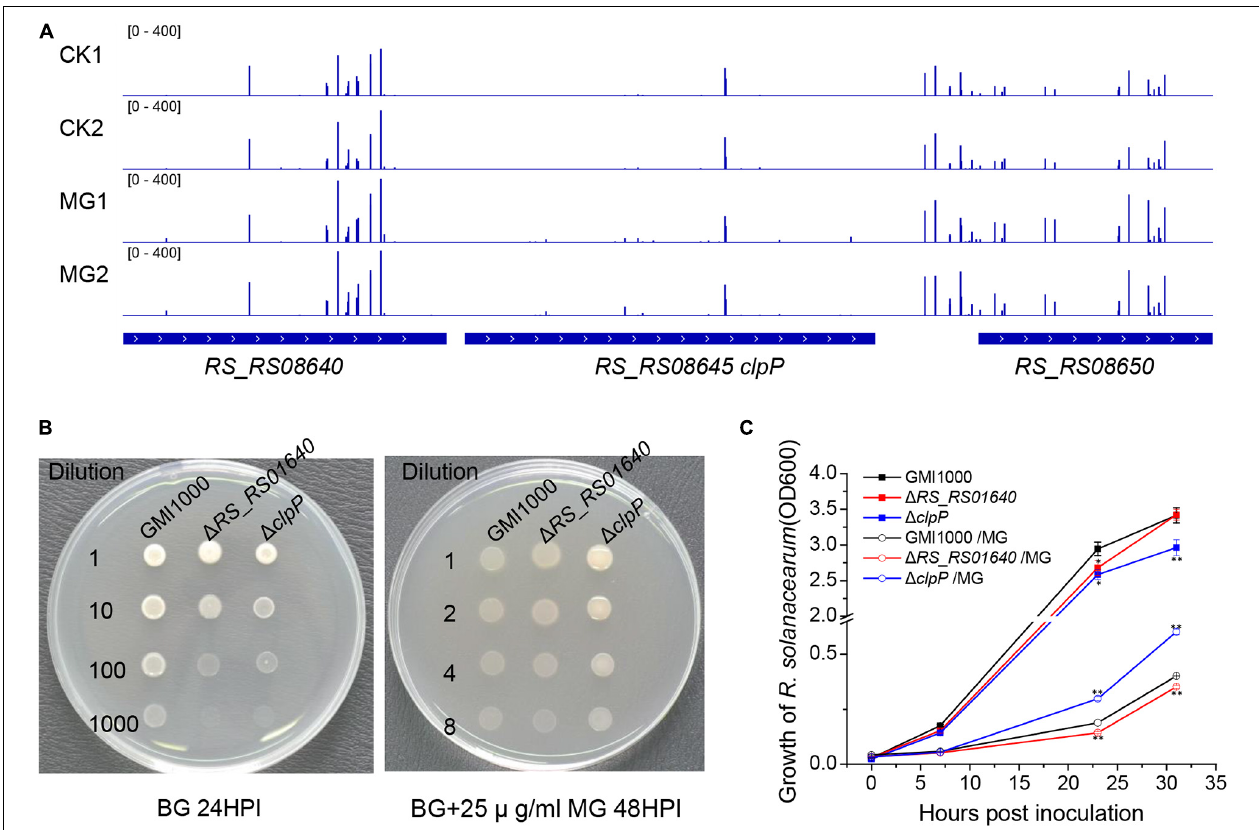
FIGURE 2 | ClpP is necessary for the antibacterial activity of methyl gallate (MG) against R. solanacearum . (A) Transposon insertion distribution of clpP and its flanking sequence. (B) Gradient diluted bacterial cultures were inoculated on BG agar medium with or without 25 µ g/ml of MG. The growth of R. solanacearum strains was observed and photographed at certain times. (C) Growth of R. solanacearum strains cultured in BG liquid medium with or with 25 µ g/ml of MG. Growth differences between mutants and the wild-type strain GMI1000 with or without treatments at 23 and 31 h post inoculation are marked with asterisks, indicating P < 0.01 (**) or P < 0.05 (*), statistically analyzed by analysis of variance